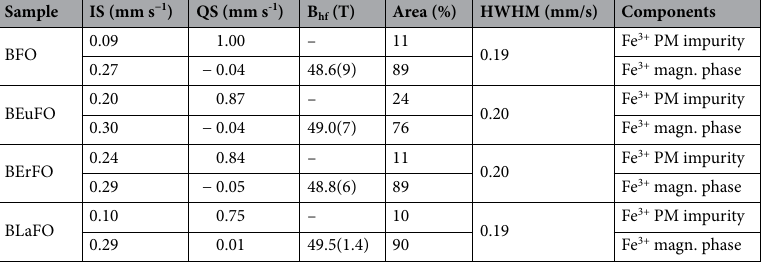
Table 2. The hyperfine parameters obtained from the Mössbauer spectroscopy measurements at room temperature (IS—isomer shift, QS—quadrupole splitting, B hf —magnetic hyperfine field). PM paramagnetic, HWHM Lorentzian